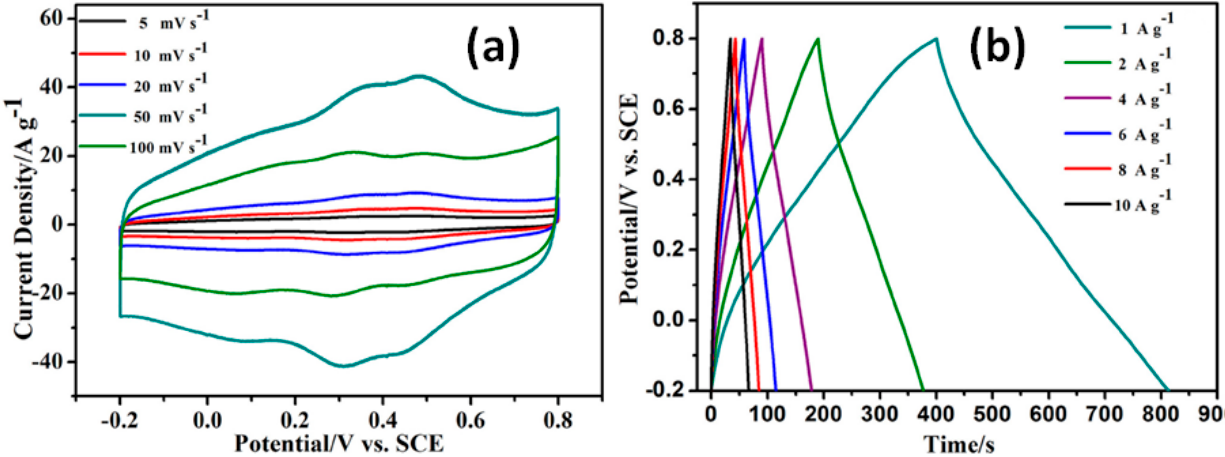
Figure 14. CV curves at different scan rates ( a ) and GCD curves at different current densities ( b ) of rGO/CNT/PANI (Reproduced with permission of [38]. Copyright Elsevier, 2018).